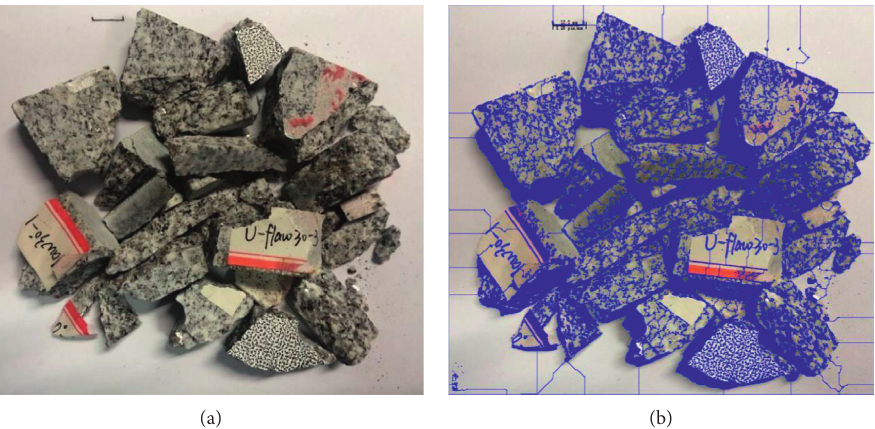
Figure 12: Rock fragmentation pictures of Group U-30: (a) rock fragments and (b) processed picture by split desktop